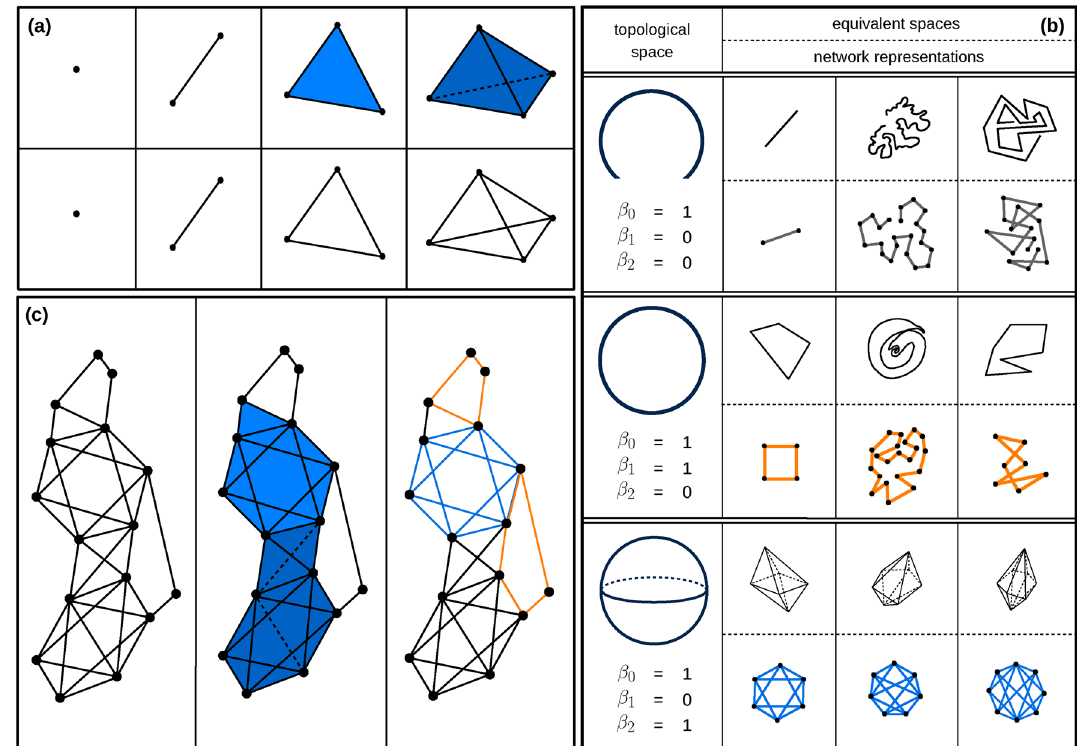
Figure 1. (a) 0-,1-,2-, and 3-simplex from left to right (Up row), and their network representation (bottom row). (b) Example of some topological spaces with their associated Betti numbers (left column), and the equivalent spaces and their network representation (right column). (c) An example for constructing the associated clique simplicial complex (middle column) from an unweighted network of nodes and links (left column), and its network representation with its topological features(right column). In network representation, orange and blue subnetworks correspond to 1-holes (loops) and 2-holes (voids), respectively. The network has the Betti vector of � β = ( 1, 2, 1 )